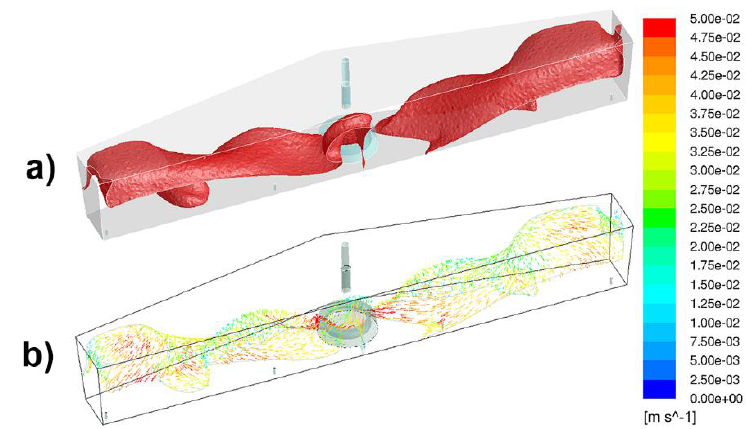
Figure 12. Tracer mixing kinetics for TI1: ( a ) Isoconcentration surface in mass fraction of a tracer 300 s after its injection in the ladle shroud and ( b ) associated velocity field. Isoconcentration surface in mass fraction is 2.6 × 10 −5 .